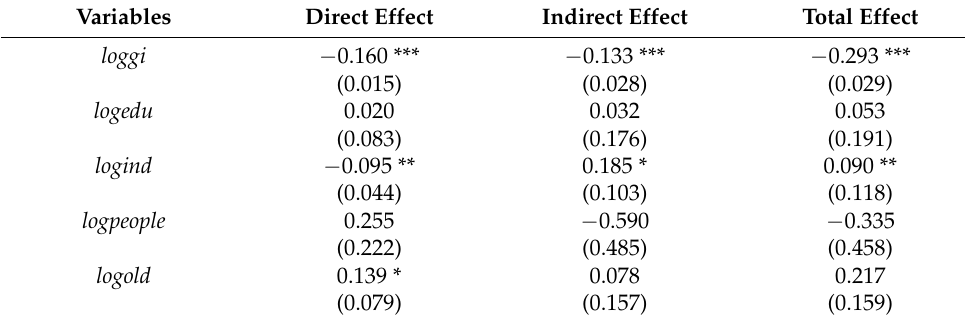
Table 7. Direct effect, indirect effect, and total effect of